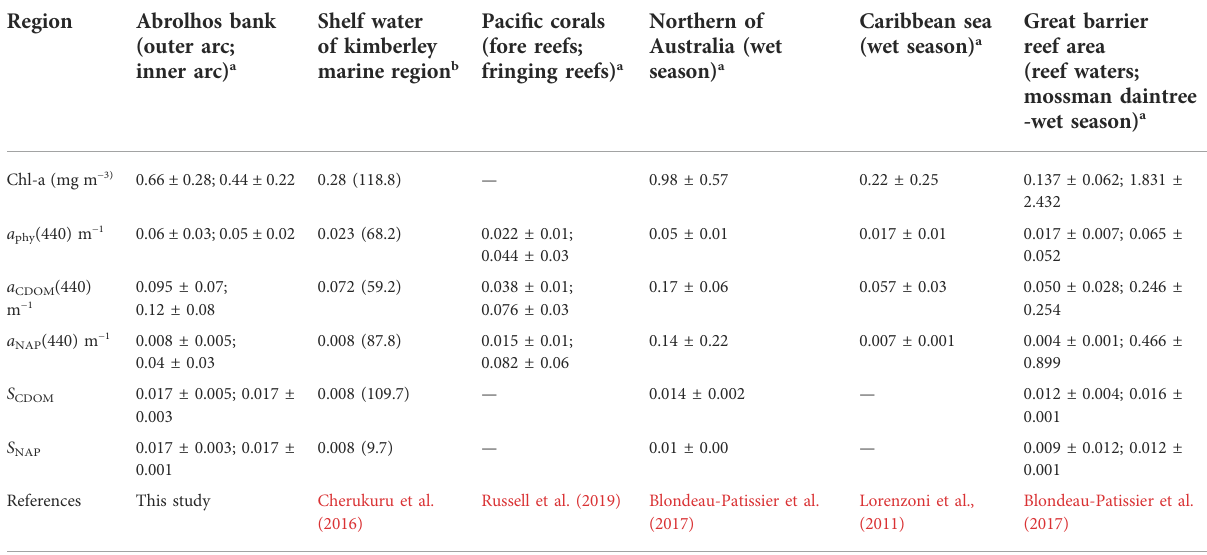
TABLE 6 Comparison between the optical properties of different coastal areas in the world. Region Abrolhos bank (outer